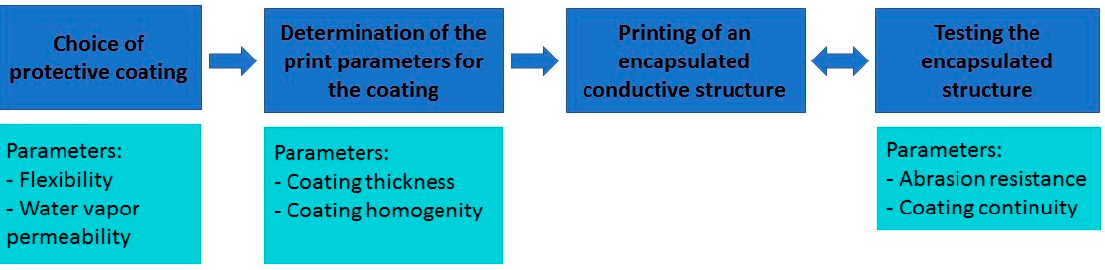
Figure 1. Methodology of the study.